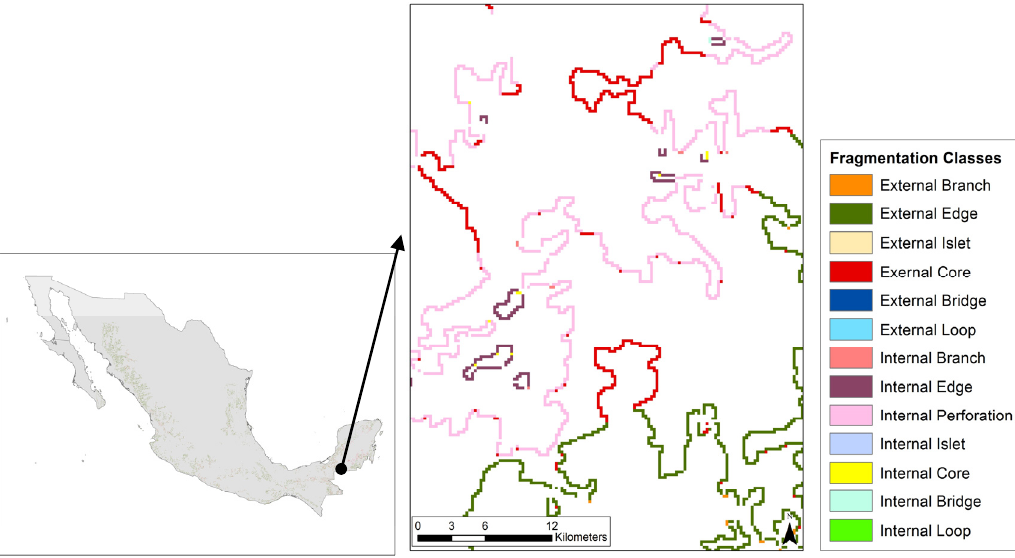
Figure 6. Example of internal and external fragmentation classes in 2008 that fall within the 2002– External ‐ Edge class for a sample area of tropical forests.